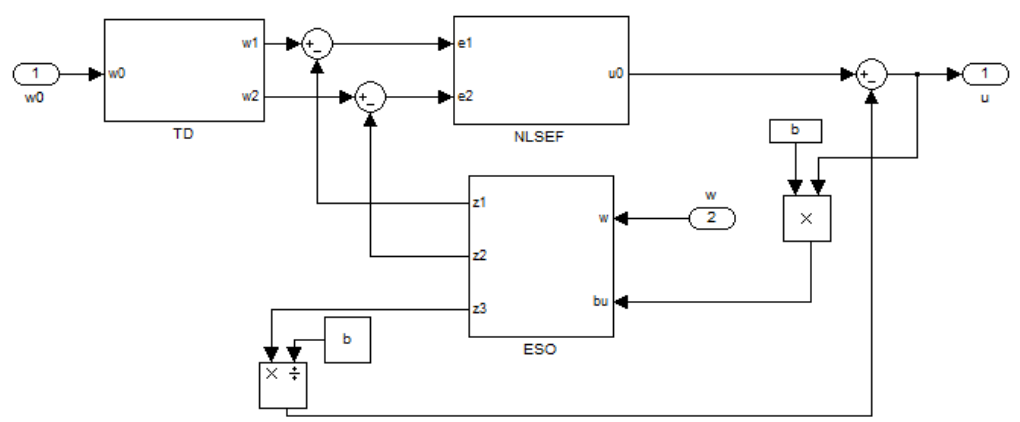
Figure 13. The Simulink model of the active disturbance rejection controller.